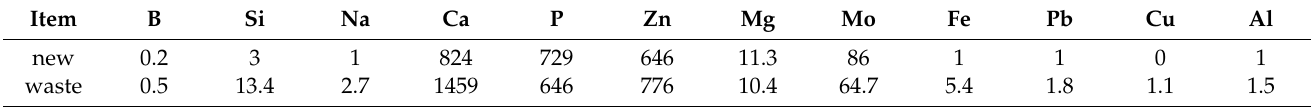
Table 2. The element contents of new engine oil and waste engine oil (unit: µ